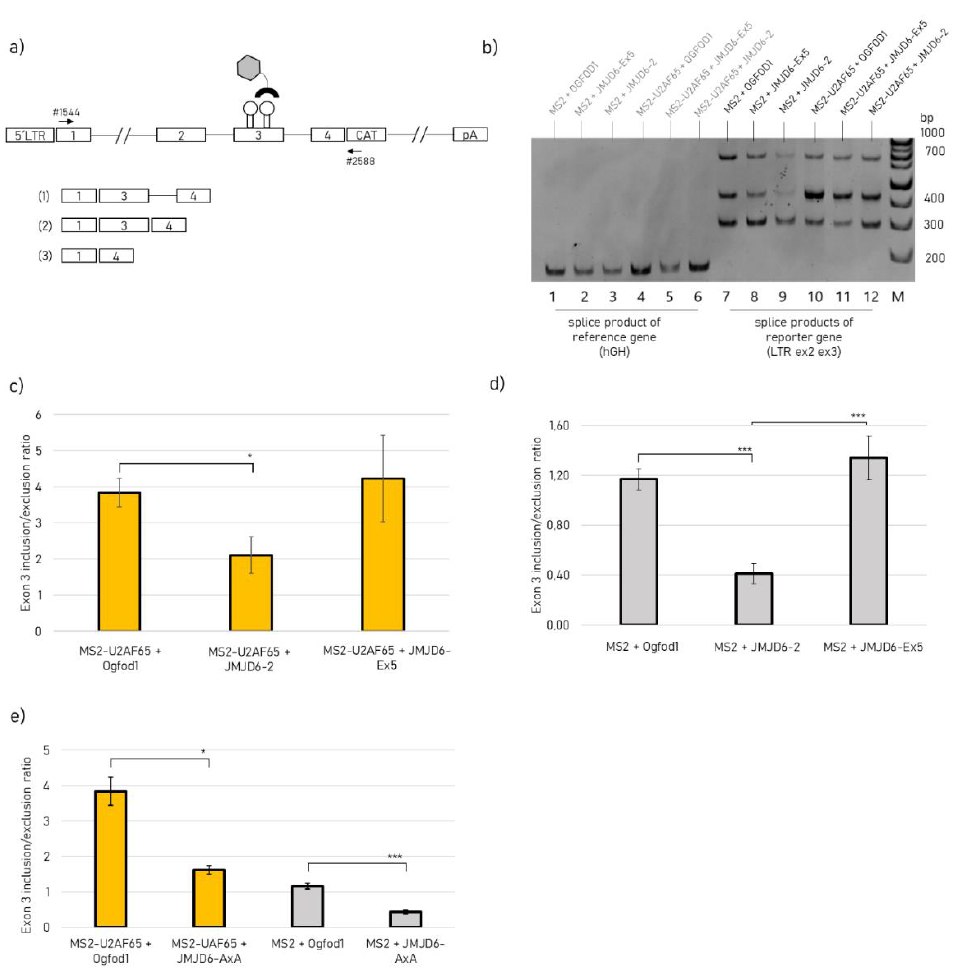
Figure 5. HIV-1-based splicing reporter with JMJD6-2, JMJD6-Ex5 and the catalytic inactive mutant JMJD6-AxA. ( a ) Schematic image of the LRT ex2 ex3 reporter gene construct with MS2 binding sites within exon 3 and the primers #1544 and #2588 marked with arrows. Image modified from Singh et al. (2010) [27]. The three possible splicing products that result from differential usage of the HIV-1 exon 3 splice sites SA2 and SD2 are indicated below and were separated by ( b ) a native PAGE after amplification of the splicing products using PCR. Of note, no inclusion of exon 2 into the reporter mRNAs can be detected due to weak intrinsic strength of HIV-1 exon 2 5 (cid:48) ss D2 and deletion of